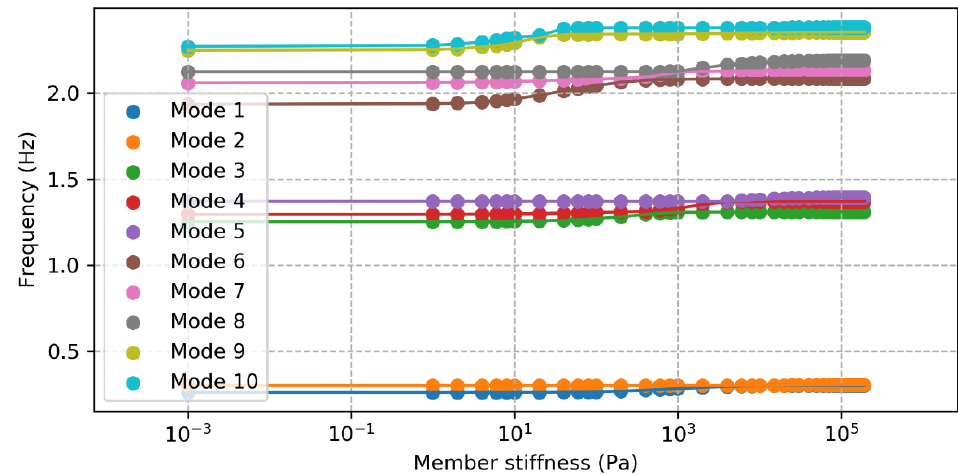
Figure 2. Example case showing the eigenfrequencies of the first 10 modes as the stiffness of a leg element is reduced from design stiffness to complete loss of stiffness.